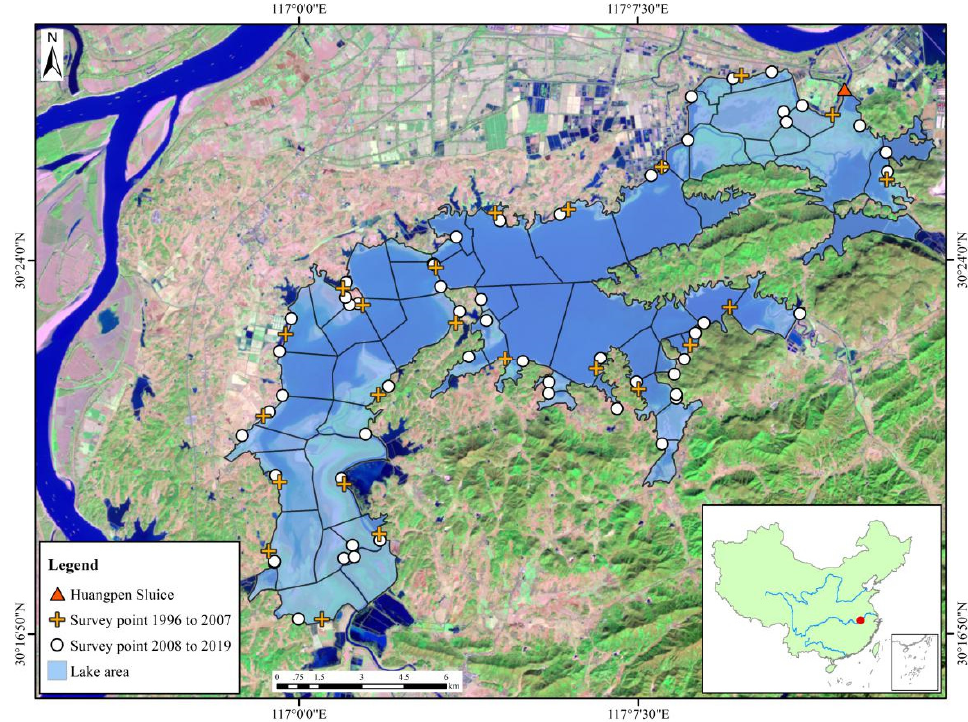
Figure 1. Location of Shengjin Lake National Reserve in China and the waterbird monitoring design.